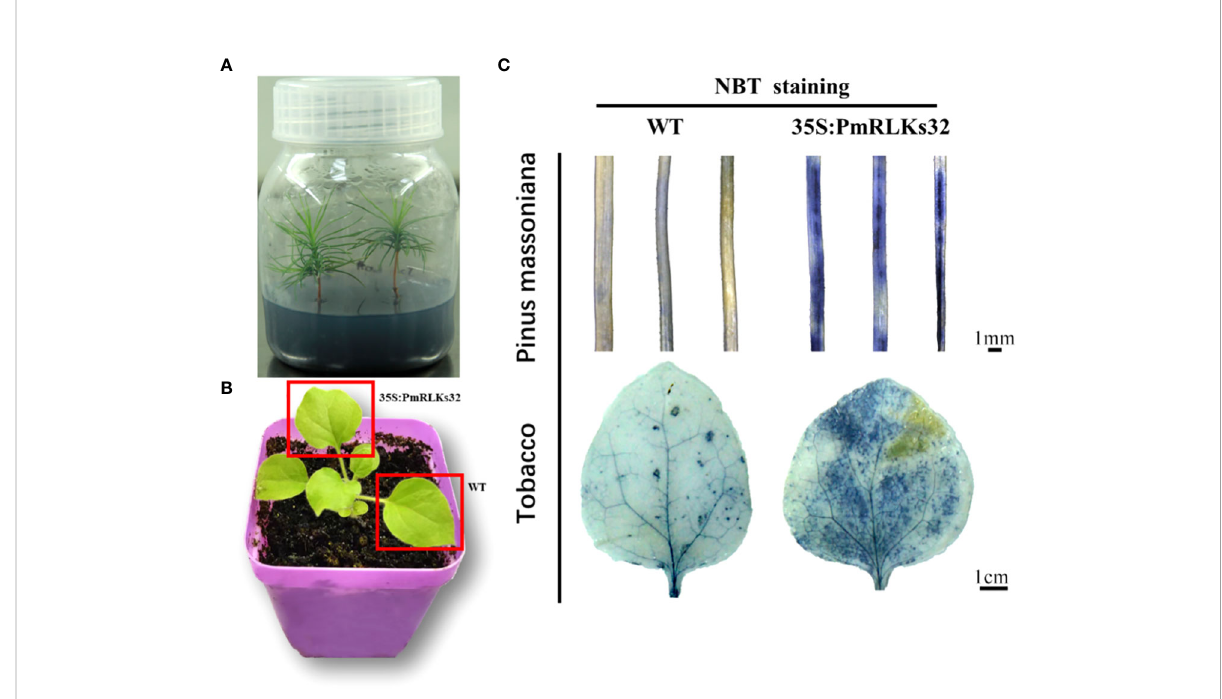
FIGURE 6 Staining of reactive oxygen species with nitro blue tetrazolium (NBT). (A) Tissue-cultured seedlings of Pinus massoniana . (B) Material of Nicotiana benthamiana : leaves used for transient transformation with the 35S: PmRLKs32 construct are indicated by red boxes. (C) NBT staining of needles of P. massoniana (upper) and leaves of N. benthamiana